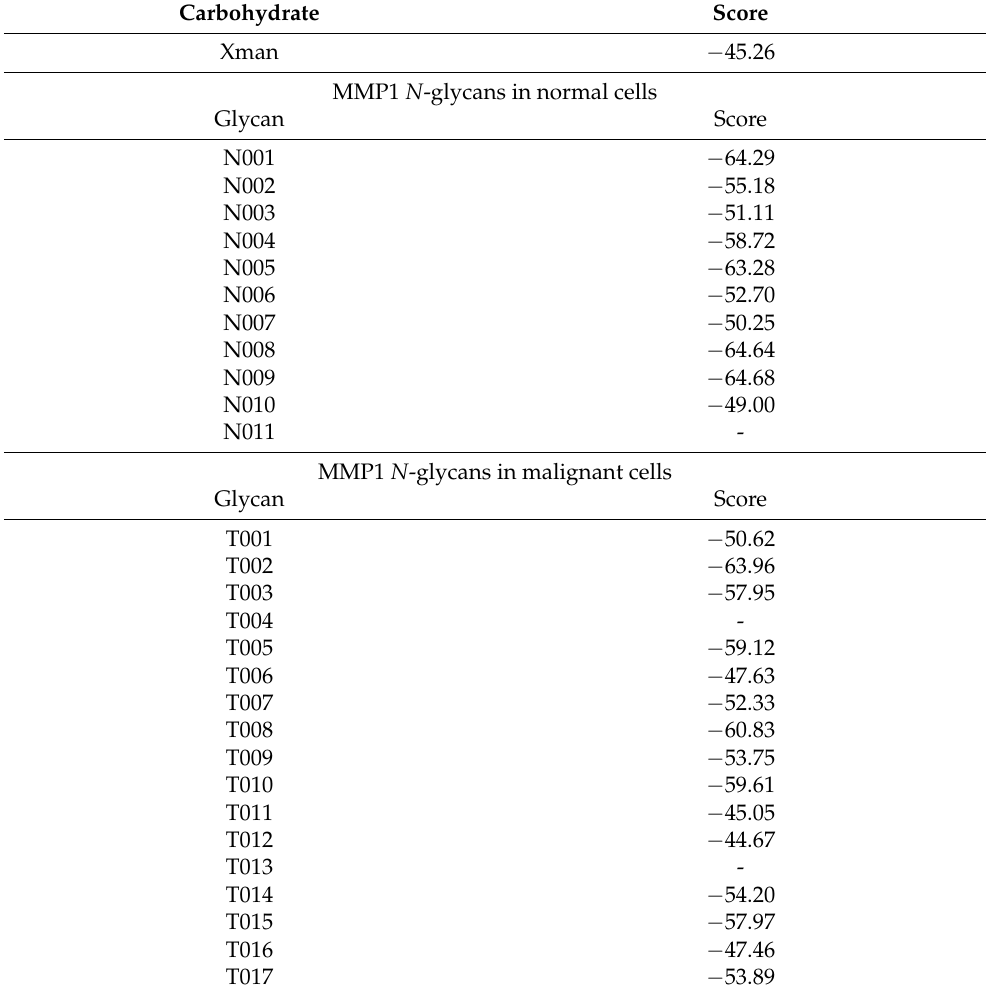
Table 1. Interactions of ConGF with Xman and MMP1 N